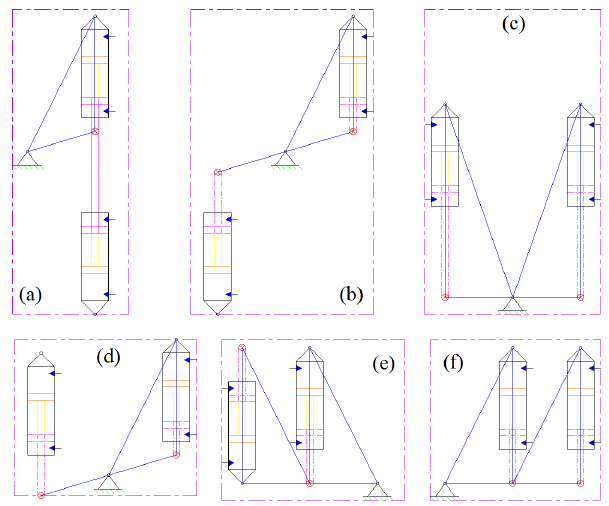
Figure 3. Layout diagrams of a parallel electrohydraulic